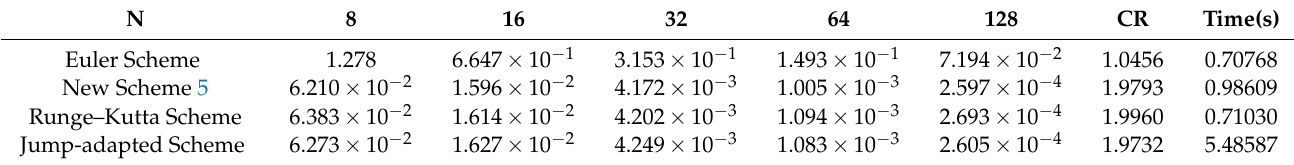
Figure 3. ( Left ) The global samples errors and CPU time of Example 4; and ( Right ) the global samples errors and CPU time of Example 5. Table 3. Errors and convergence rates of schemes with the parameters of Example